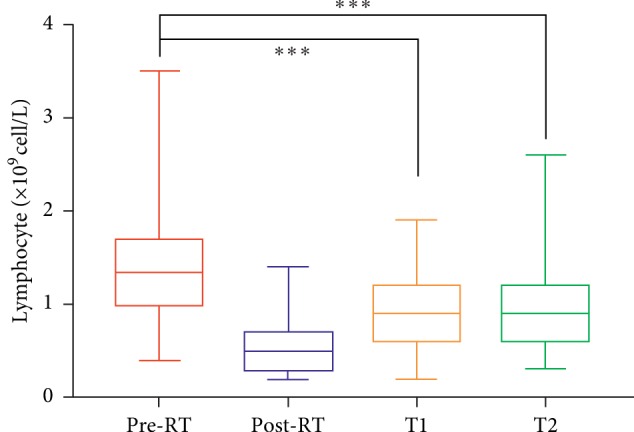
Alteration of lymphocyte count during radiotherapy (RT). Comparison of lymphocyte counts at pre-RT, post-RT, first follow-up (T1), and second follow-up (T2) (all p < 0.001).